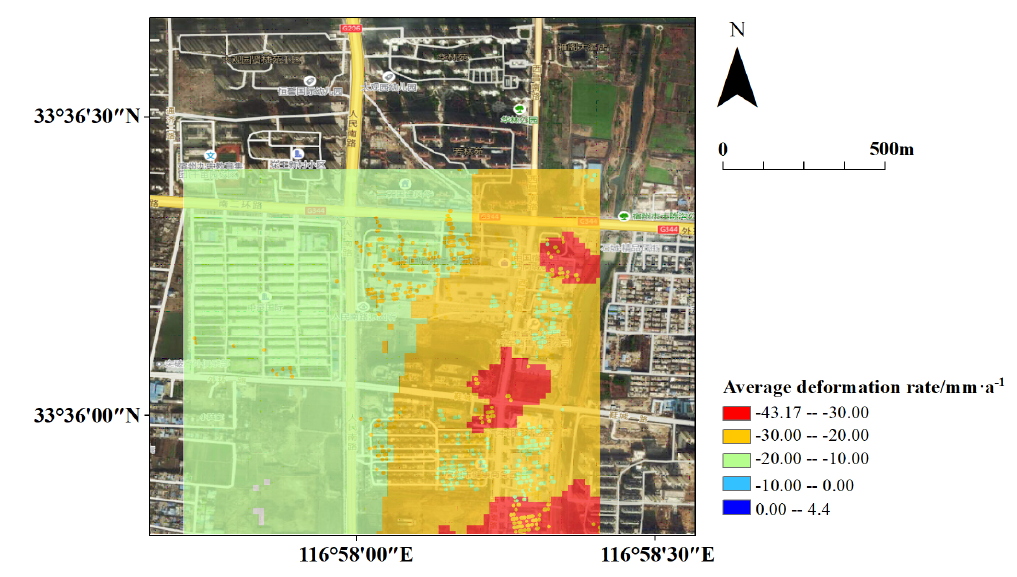
Figure 9. Local subsidence difference of the study